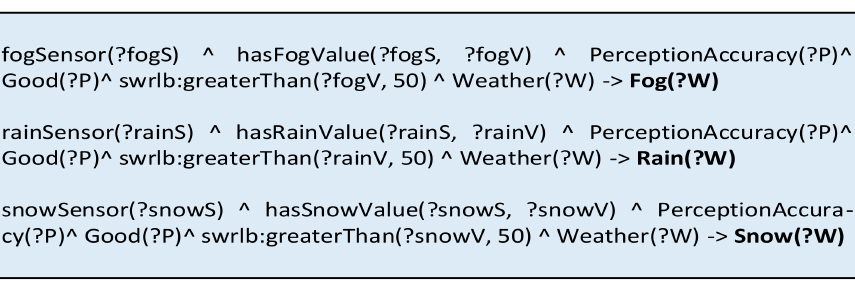
Figure 13. Detection of weather using sensors.